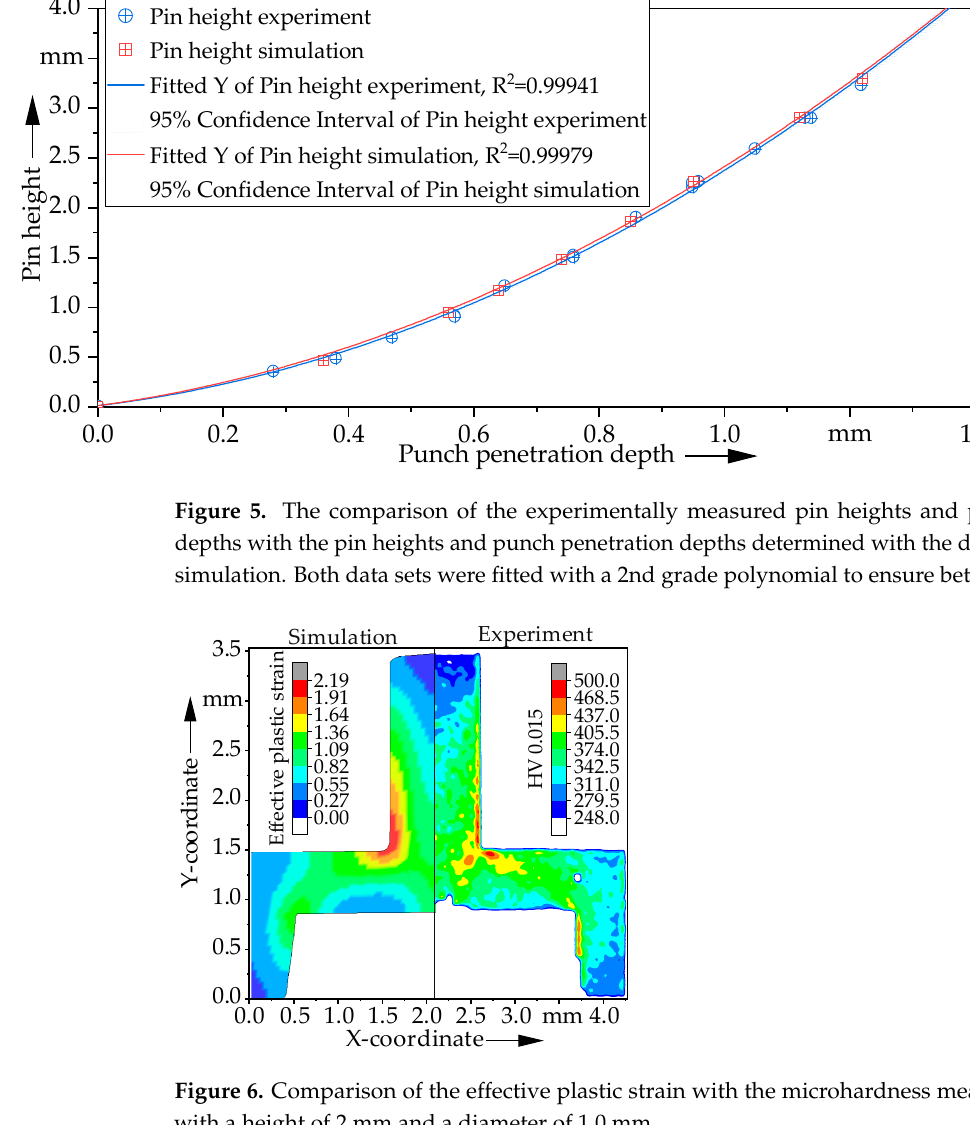
Figure 6. Comparison of the effective plastic strain with the microhardness measurement of a pin with a height of 2 mm and a diameter of 1.0 mm.